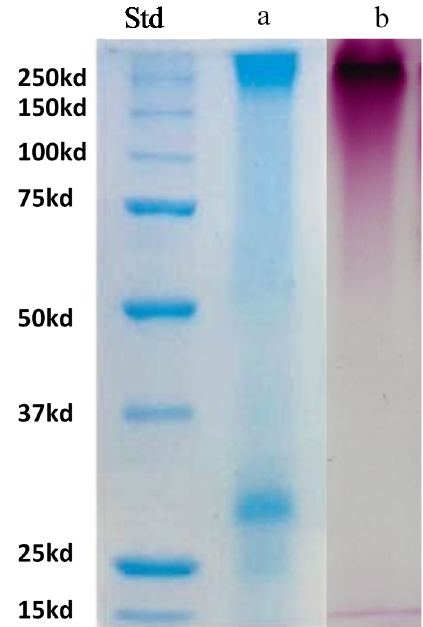
Figure 2. Sodium dodecyl sulfate-polyacrylamide gel electrophoresis (SDS-PAGE) of the freeze-dried polysaccharides (UFS). The glycoproteins were stained on the electrophoretic gel with Bio safe Coomassie ( a ) and with Schiff’s reagent ( b ). Std: Blue precision plus molecular weight standards.